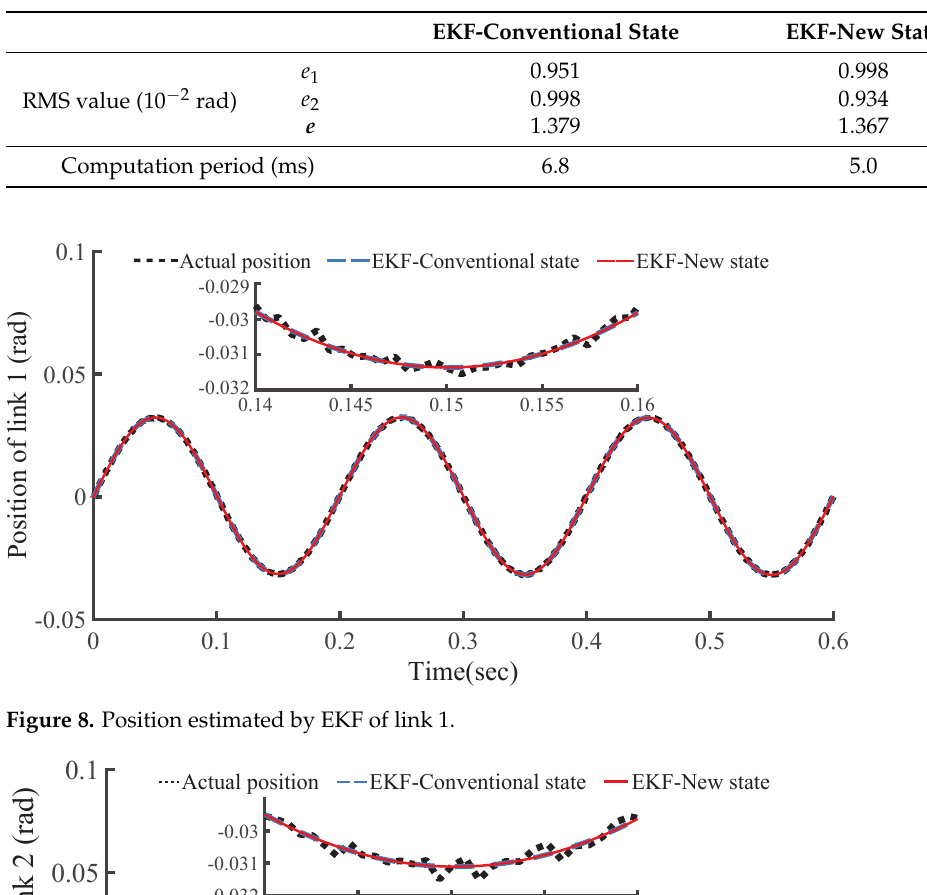
Table 1. Comparison of two EKFs.